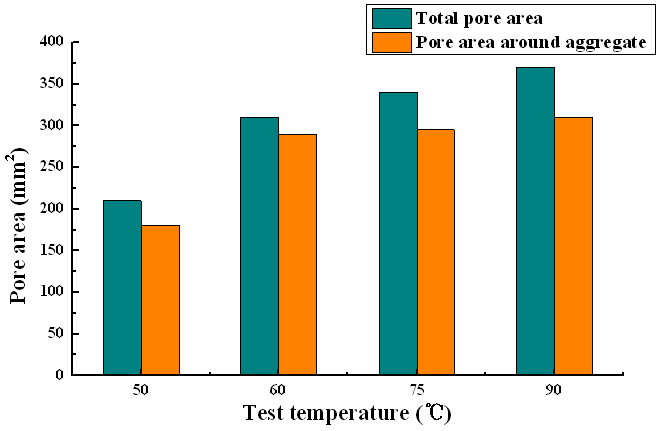
Figure 11. Comparison of total pore and surrounding pore of aggregate at each temperature [79].